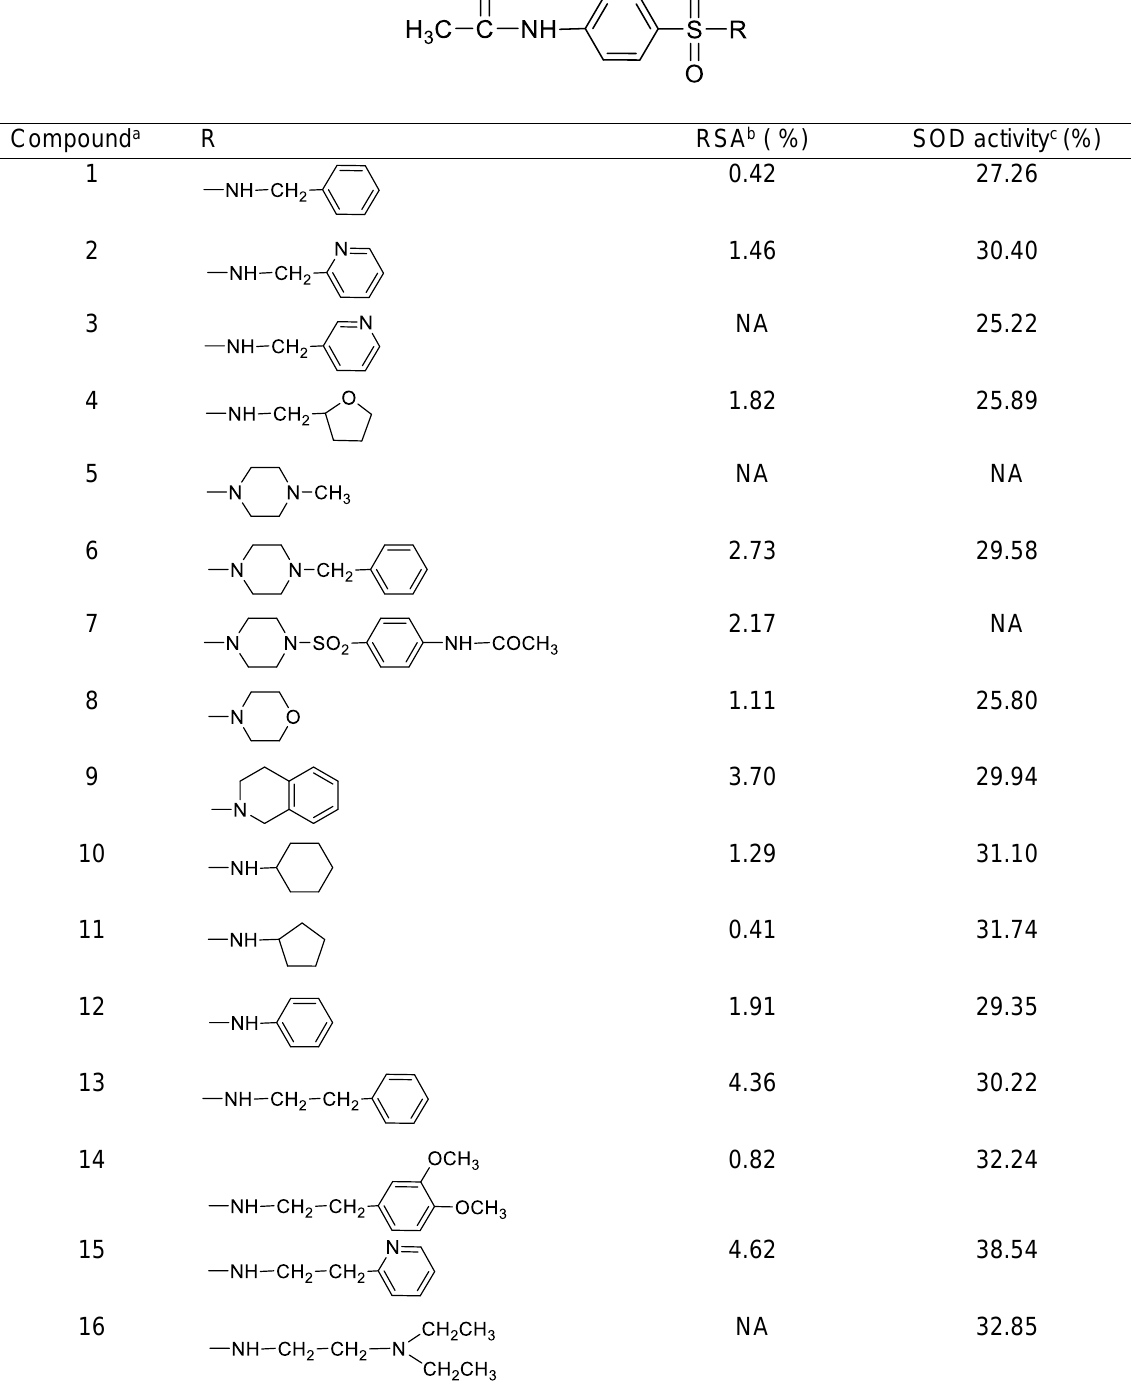
Table 1: Antioxidant activities (RSA and SOD) of sulfonamide derivatives